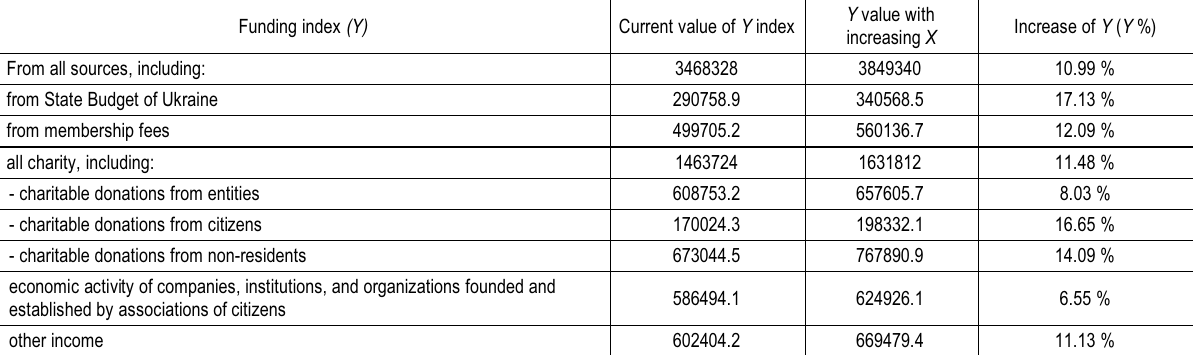
Table 11.The impact of “Gross profit and mixed income” factor and sources of funding of NGOs Funding index (Y)